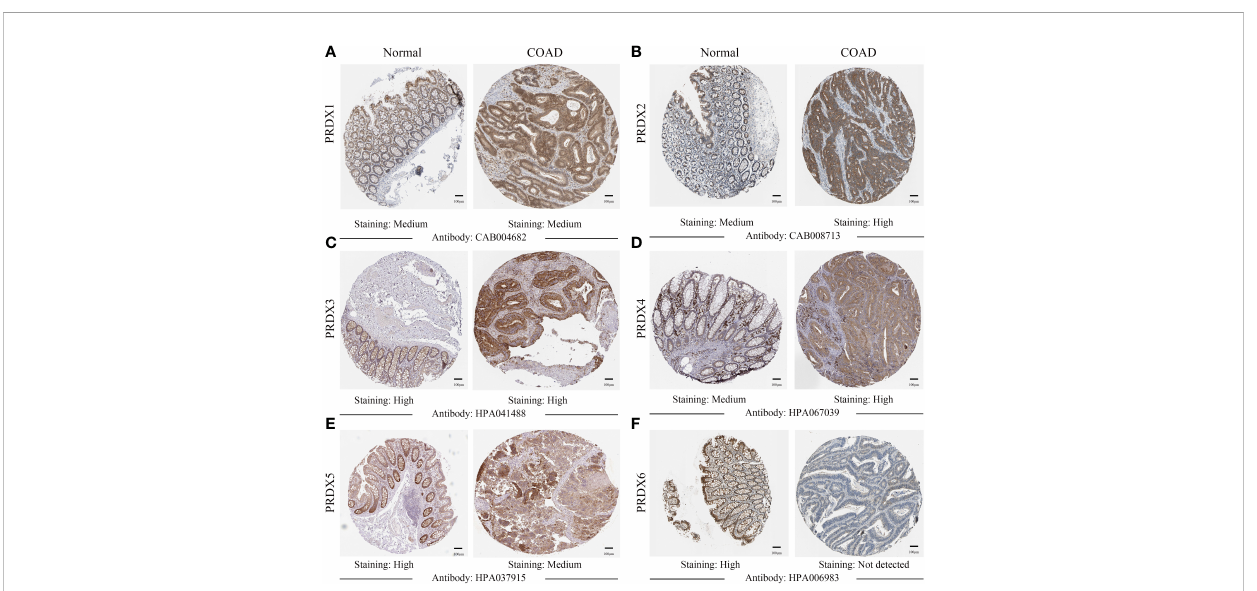
FIGURE 3 (A-F) IHC analysis of protein expression of each PRDX family member in COAD tissues and normal tissues (HPA). Brown areas in the image indicate positive expression, and blue areas indicate negative expression. IHC, immunohistochemical; COAD, colon adenocarcinoma. scale bar, 100 m